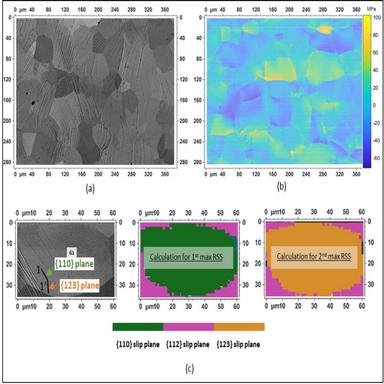
Example of comparison between experimental observations and modeling. (a) ECC image of the large area of interest (b) the map Δ = − − ℎ of the same zone (c) ECC image of grain G1 and slip plane maps according to the associated color code: in green grains where slip families were activated, in fuchsia grains where slip families were activated and in orange grains where slip families were activated.